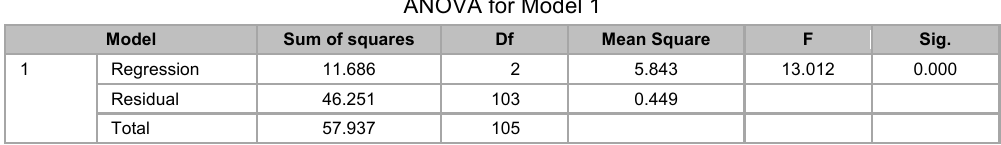
ANOVA for Model